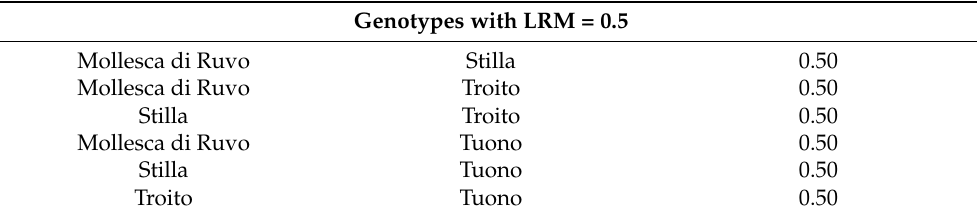
Table 2. List of pairwise relatedness based on the LRM